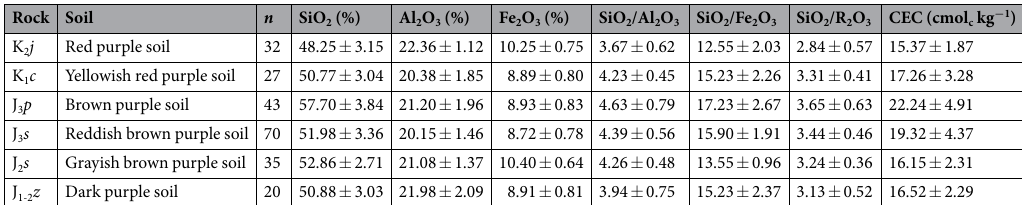
Table 6. SiO 2 /Al 2 O 3 , SiO 2 /Fe 2 O 3 and SiO 2 /R 2 O 3 ratios in the clay fractions of the purple soils. Note: CEC, cation exchangeable